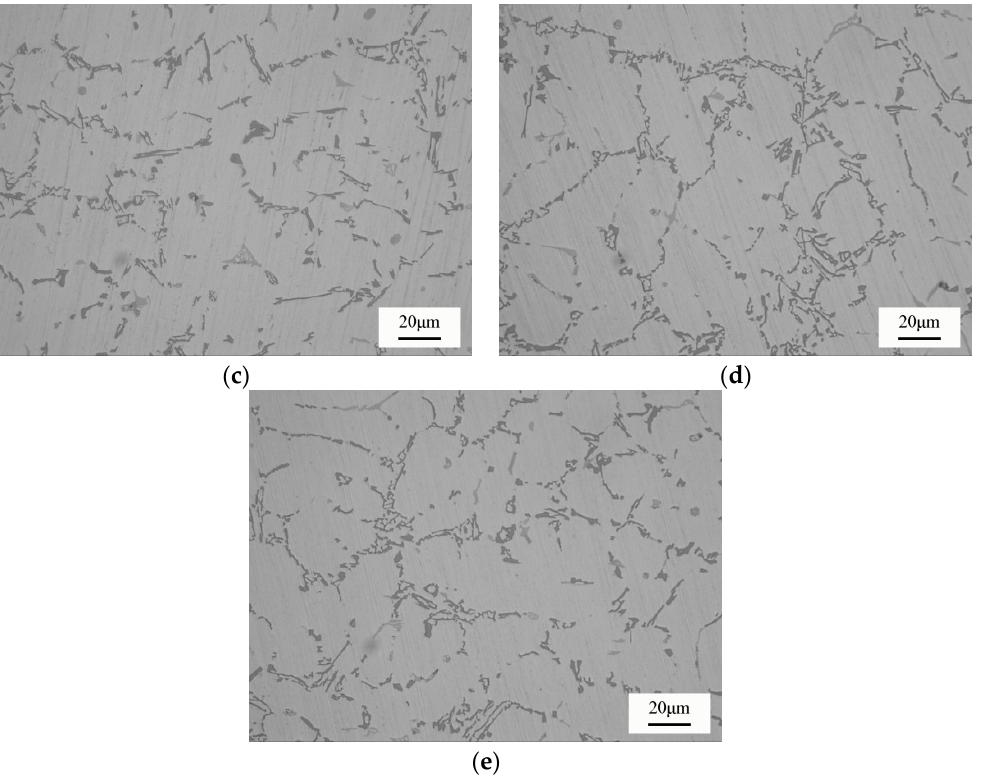
Figure 8. As-cast high magnification light optical micrographs of A357 alloy with different Ce content. ( a ) 0%, ( b ) 0.08%, ( c ) 0.16%, ( d ) 0.24%, and ( e ) 0.32%.